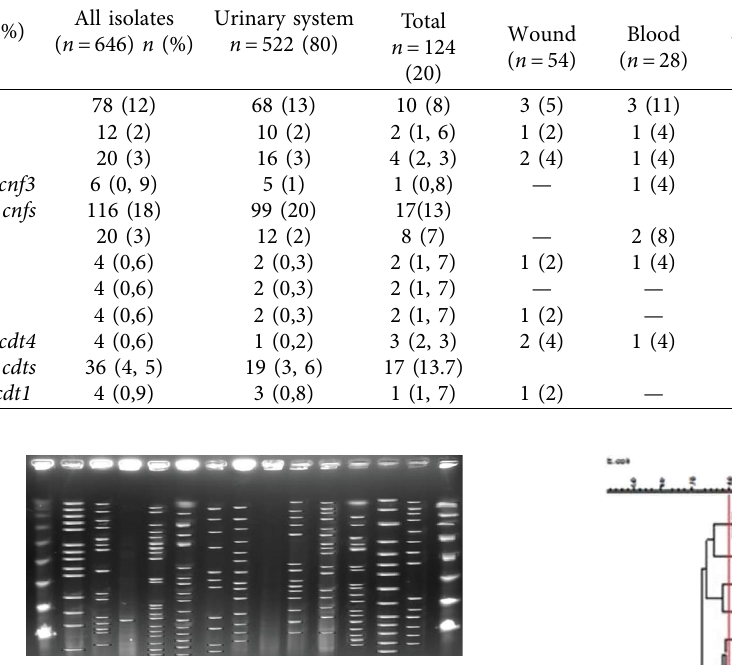
Figure 5: PFGE resulting band profles.